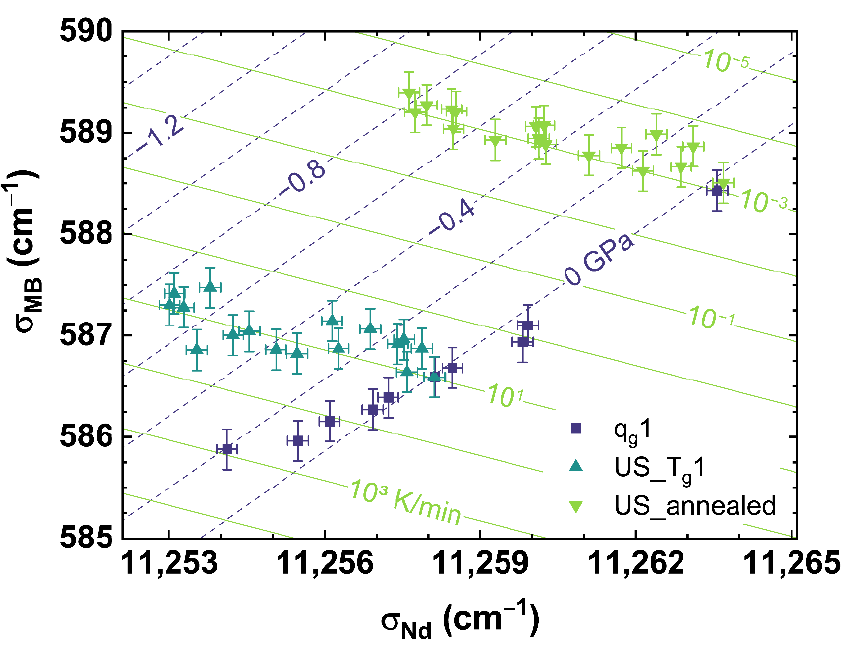
Figure 8. Observable comparison of σ MB over σ Nd for q g 1 (dark blue squares), US_T g 1 (cyan up triangles) and US_annealed (light green down triangles). The shown lines can be read as contour map based on the multiple linear regression models. The dark blue dashed lines indicate applied uniaxial stress, the light green lines indicate different cooling rates corresponding to the displayed values.